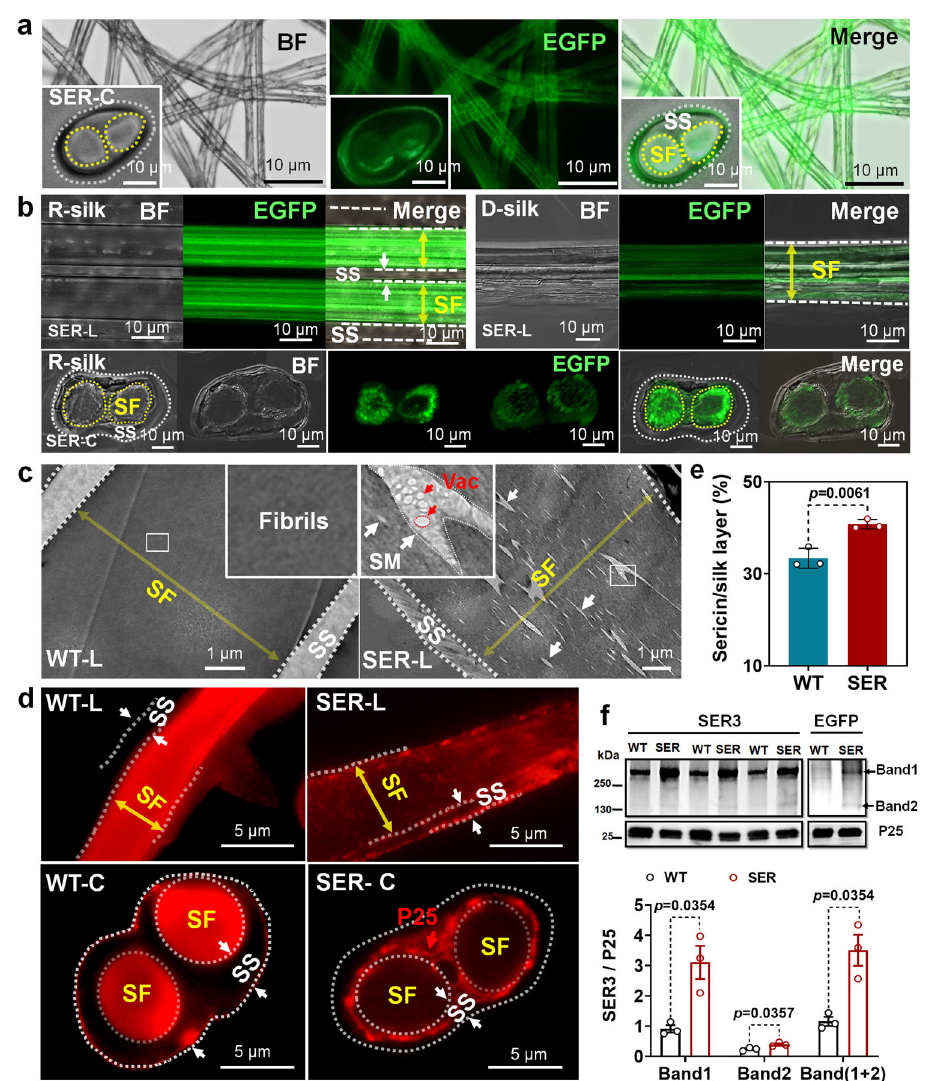
the comparison between the two groups. n =3 cocoons. f The content of SER3 protein in cocoon silk is determined by western blotting; P25 is an internal refer- ence. n =3. EGFP localization showed that the recombinant SER3 protein had haploid and dimer 2 types, and dimer was the main type. Data were presented as mean±SEM. Image data are representative of three independent experiments unless otherwise